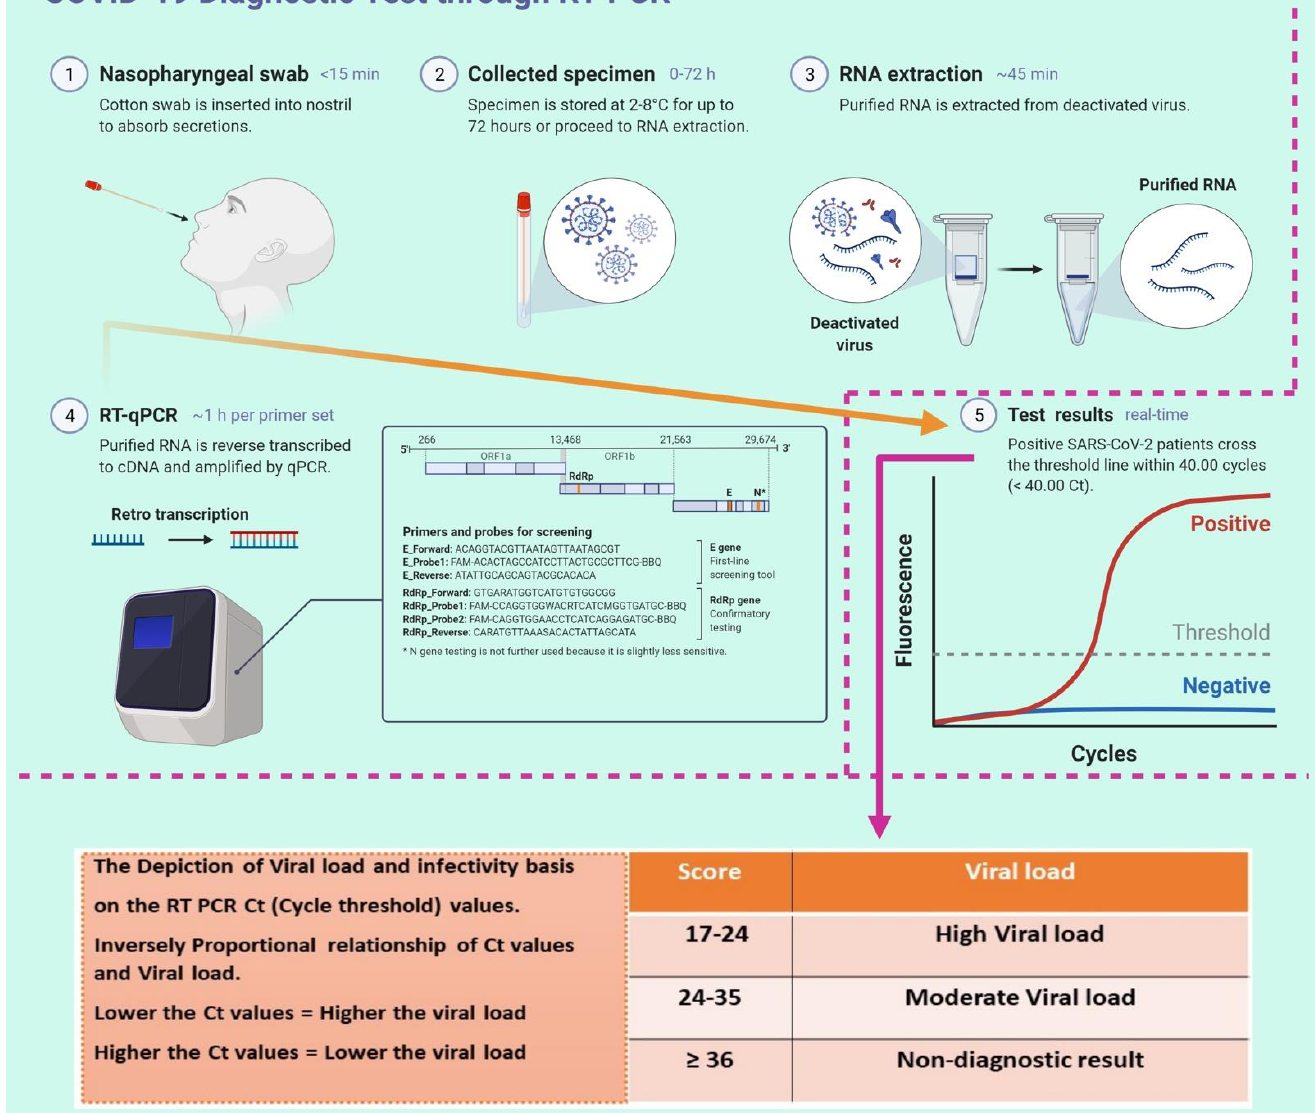
Figure 1. Schematic illustration of RT-PCR methodology and the detection of a positive sample in clinical practice, using a specific threshold and Ct value. The SARS-CoV-2 viral load is inversely proportional to the Ct values, and a lower Ct value corresponds to a high viral load, indicating a higher level of infectiousness. The figure was designed by Biorender.com program (https://biorender.com/, accessed on 15 April 2021).